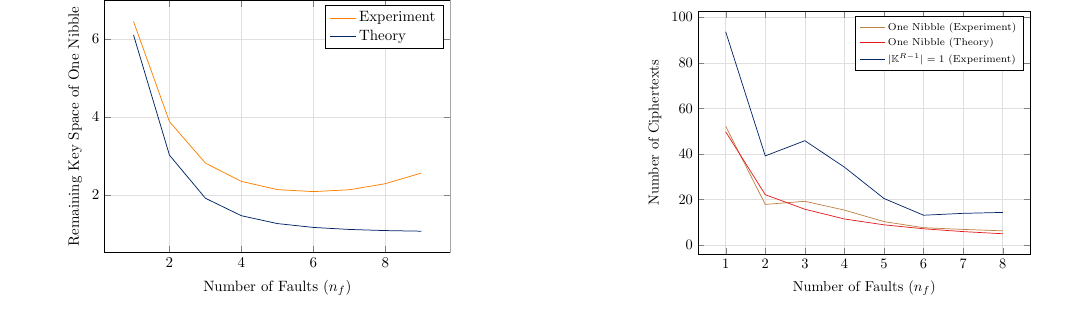
Figure 6: The number of required ciphertexts for the size of key search space to be